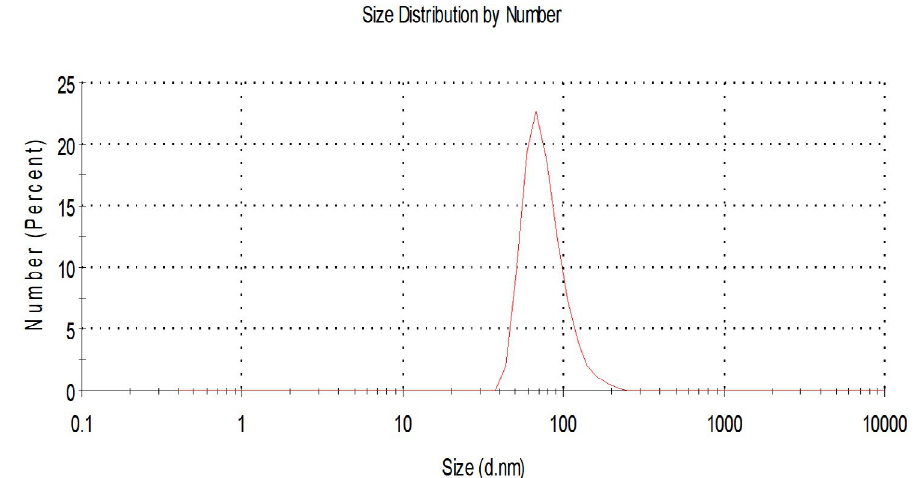
Fig.2. Histogram shows particle size distribution analyzed by Dynamic light scattering system (DLS) Zeta sizes; an average particle size based on intensity distribution for AgNPs at 56